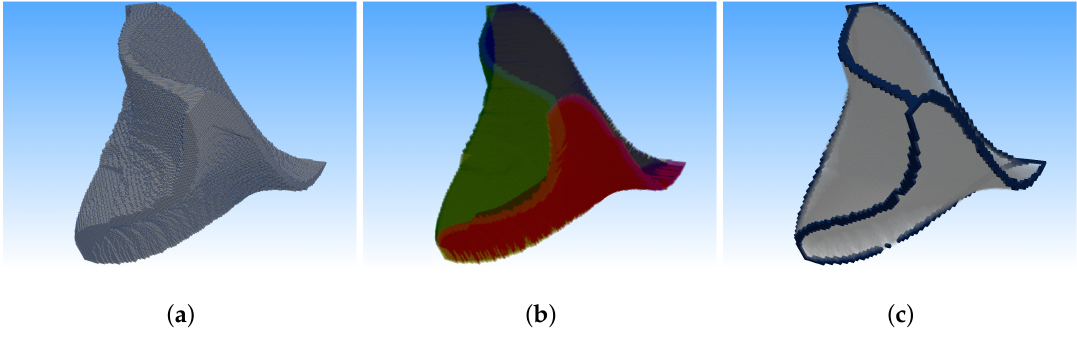
Figure 11. Visualization of the hierarchical structure of Pareto sets. ( a ) Pareto set of an example problem with J : R 3 → R 4 . ( b ) The four Pareto sets taking only three objectives into account form the boundary of the original Pareto set. ( c ) The Pareto sets in (b) are again bounded by the respective bi-objective